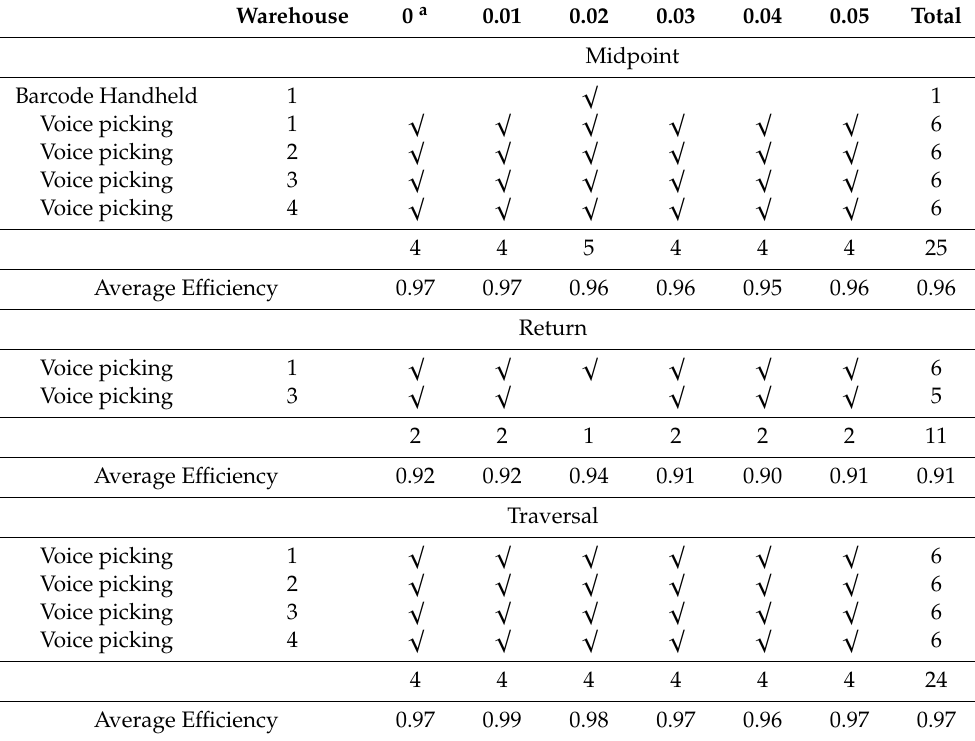
Table 7. Sensitivity analysis of the e ff ect of error on the order picking performance. Warehouse 0 a 0.01